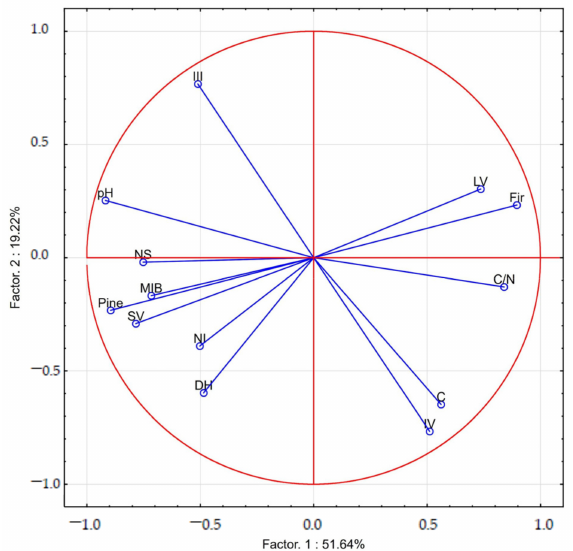
Figure 1. The projection of variables on a plane of the first and second factor in soil around deadwood (III, IV—decomposition class; MIB—mean individual carabid biomass, NI—the number of carabid individuals; NS—the number of carabid species; SV—volume of stumps; LV—volume of logs; DH—dehydrogenase